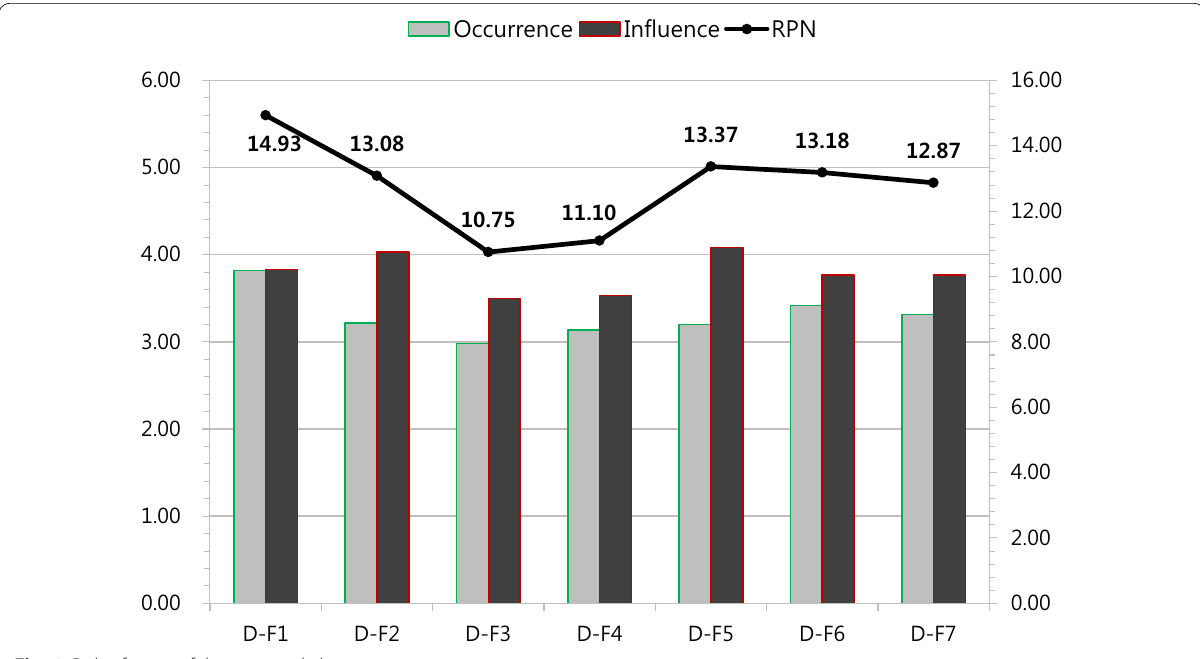
Fig. 6 Delay factors of the structural